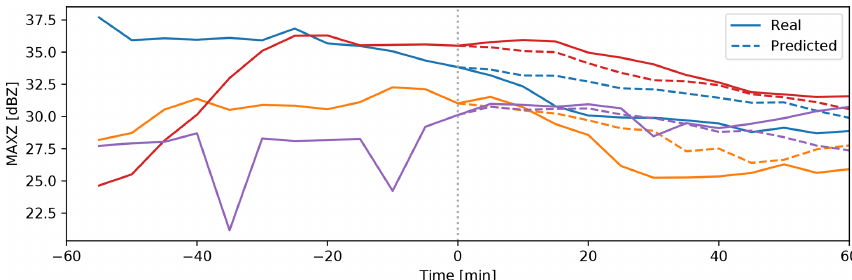
Figure 3. Examples of the prediction of MAXZ. The figure shows the curves of observed and predicted MAXZ (the mean over the 25km diameter region of interest) for four different tracked centers. The solid lines show the development of MAXZ, while the dashed lines show the predictions after t =